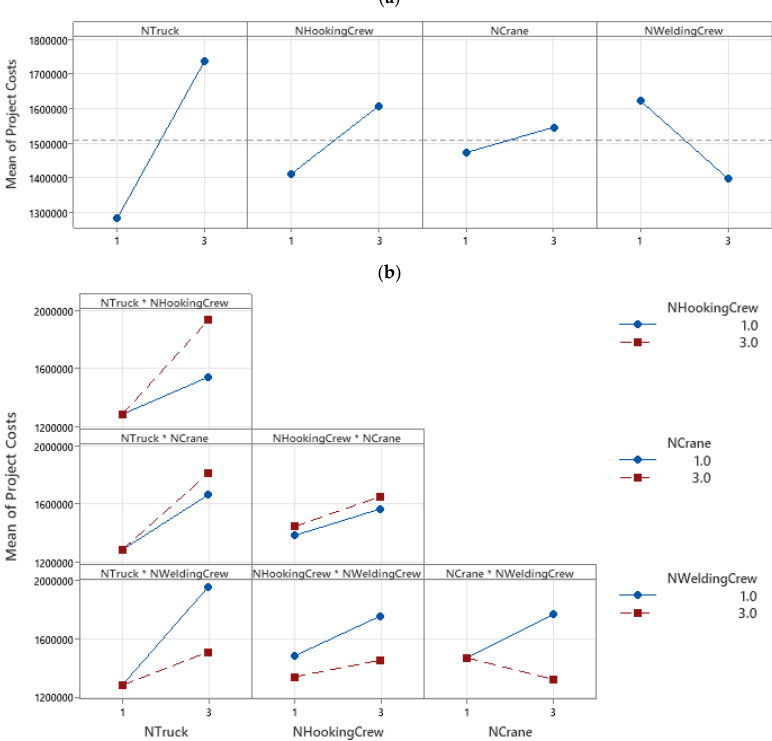
Figure 8. Significant parameters and their interactions on project costs. ( a ) Main effects plot for project costs; ( b ) interaction plot for project costs.